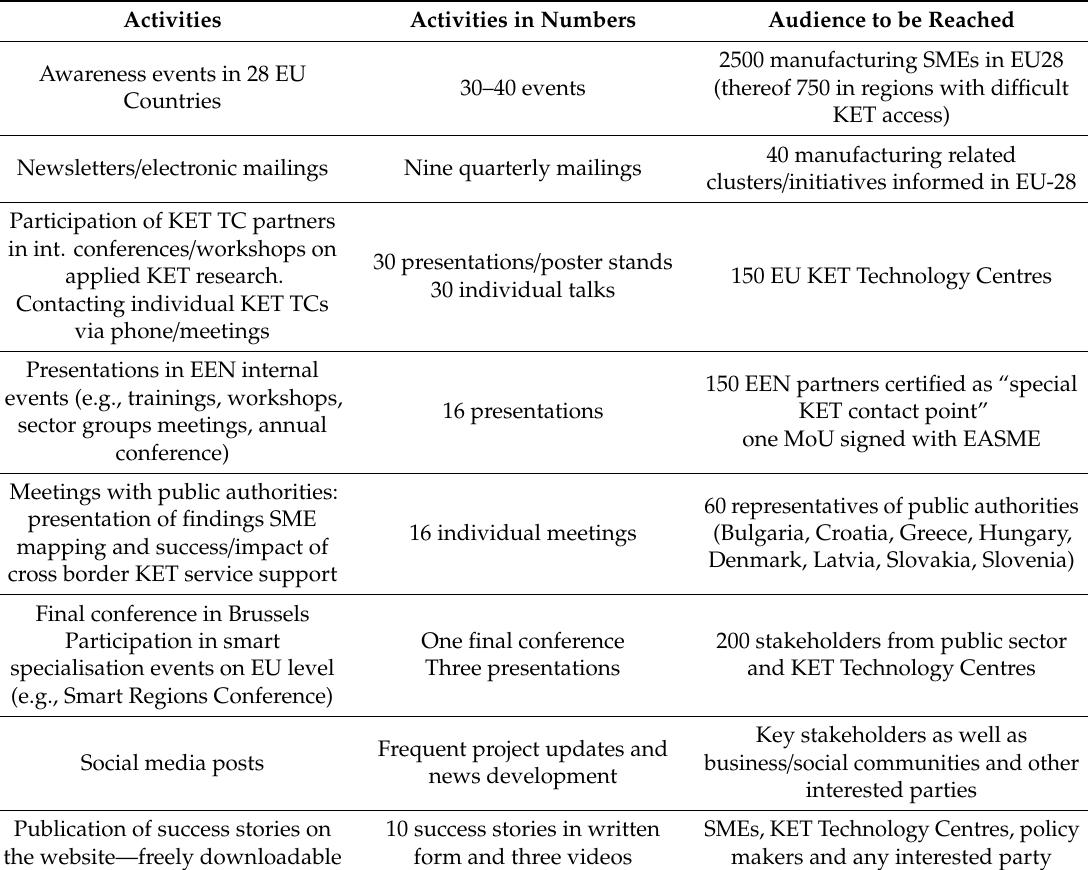
Table 1. Key elements of the dissemination and communications